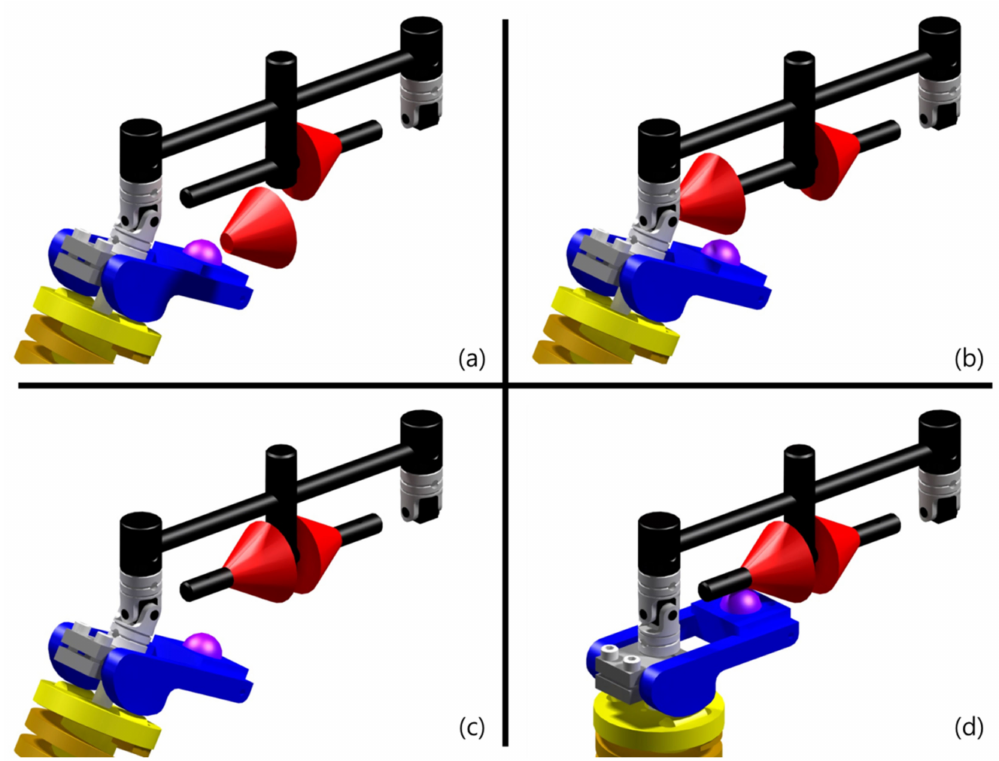
Figure 4. Assembly diagram of the payload adjustment device: ( a ) a step before the payload adjustment device is applied; ( b ) axial alignment of the axis of the pelvic link and the payload adjustment device; ( c ) coupling of the pelvic link and the payload adjustment device; ( d ) a step after the payload adjustment device is